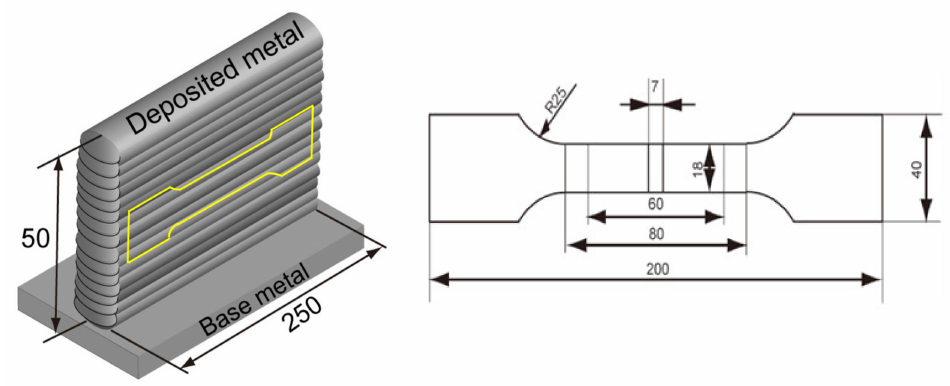
Figure 3. Large wall-type sample and cut-off plan for tensile test specimen (JIS Z2201 No.14-B).